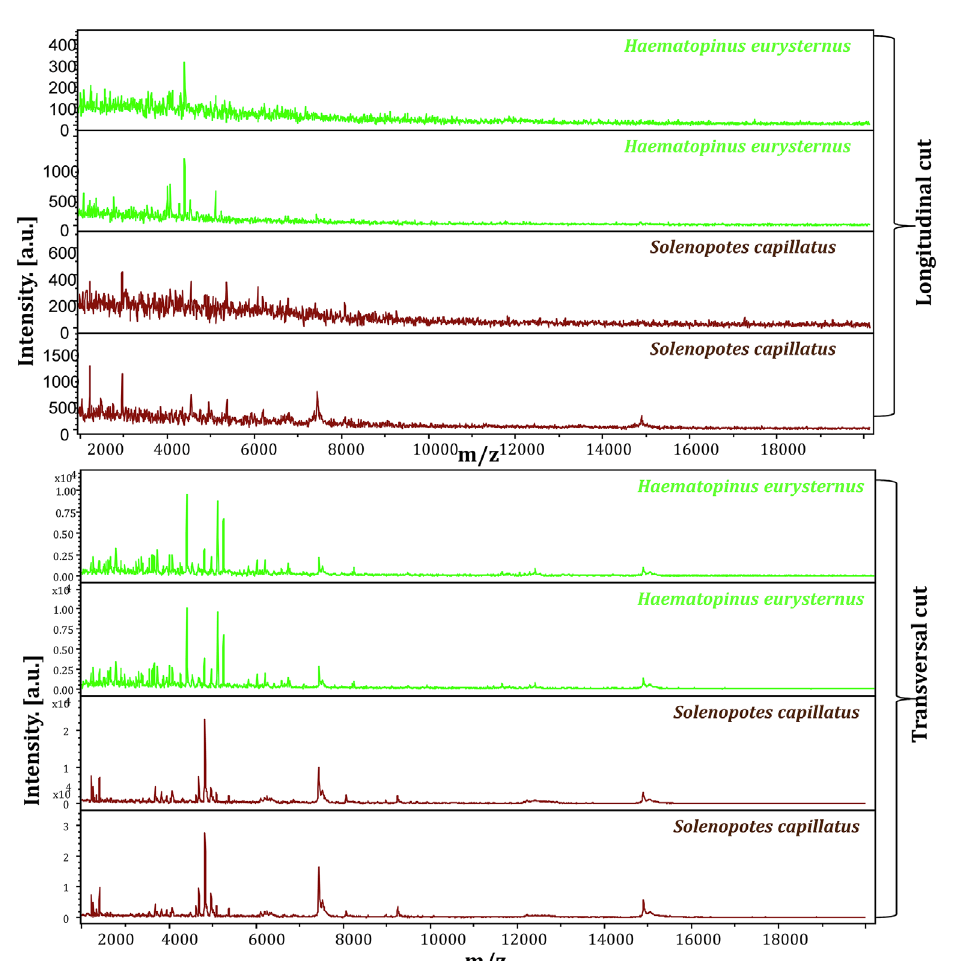
Figure 4. Comparison between the spectra obtained using protein extracts from (A) the cephalothorax and legs; (B) a longitudinal cut of the louse. Spectra were visualized using FlexAnalysis software.